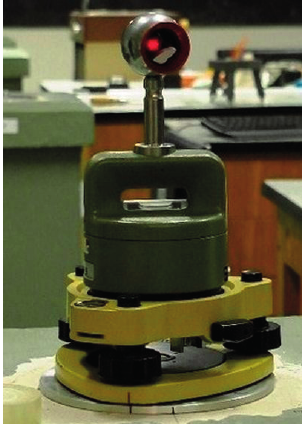
Figure 5. The test kit–tribrach Topcon, carrier Leica GZR3, Leica prism RRR 1.5 ″